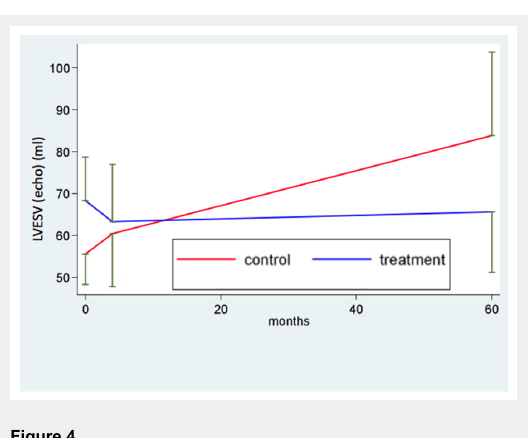
Left ventricular remodelling directly after myocardial infarction (baseline), after 4 and 60 months. LVESV: left ventricular endsystolic volume.